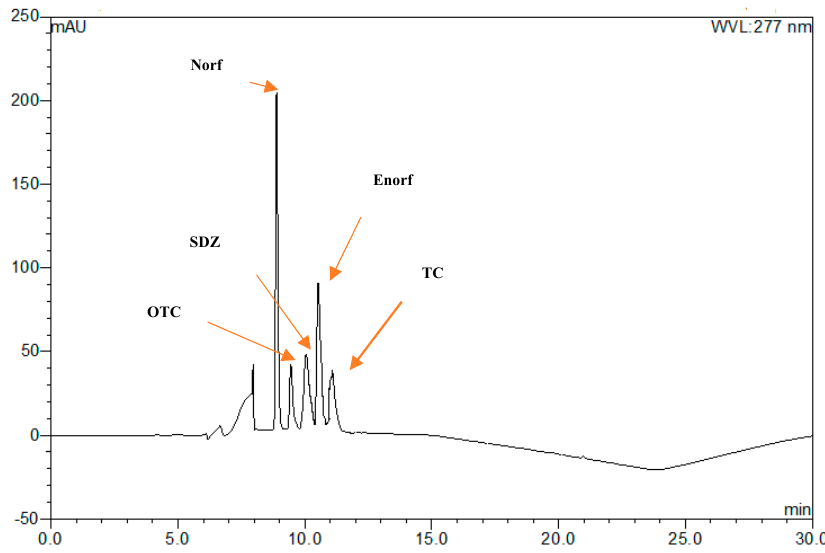
Figure 3. Chromatogram of five VAs (10 µg/mL) in swine manure; retention time = 8.7, 9.14, 9.8, 10.3, and 10.9 minutes, respectively, of Norf, OTC, SDZ, Enorf, and TC at wavelength of 277 nm.